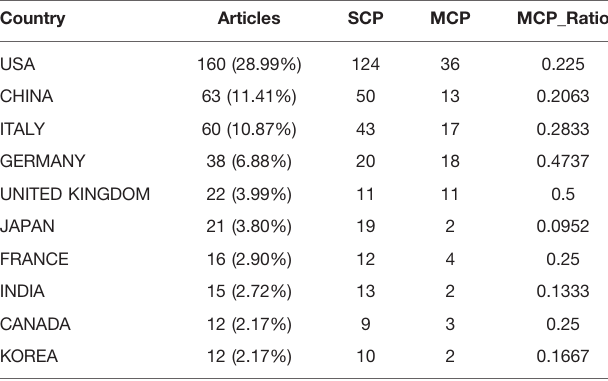
TABLE 1 | The top 10 most productive countries of stem cell precision medicine research. Country